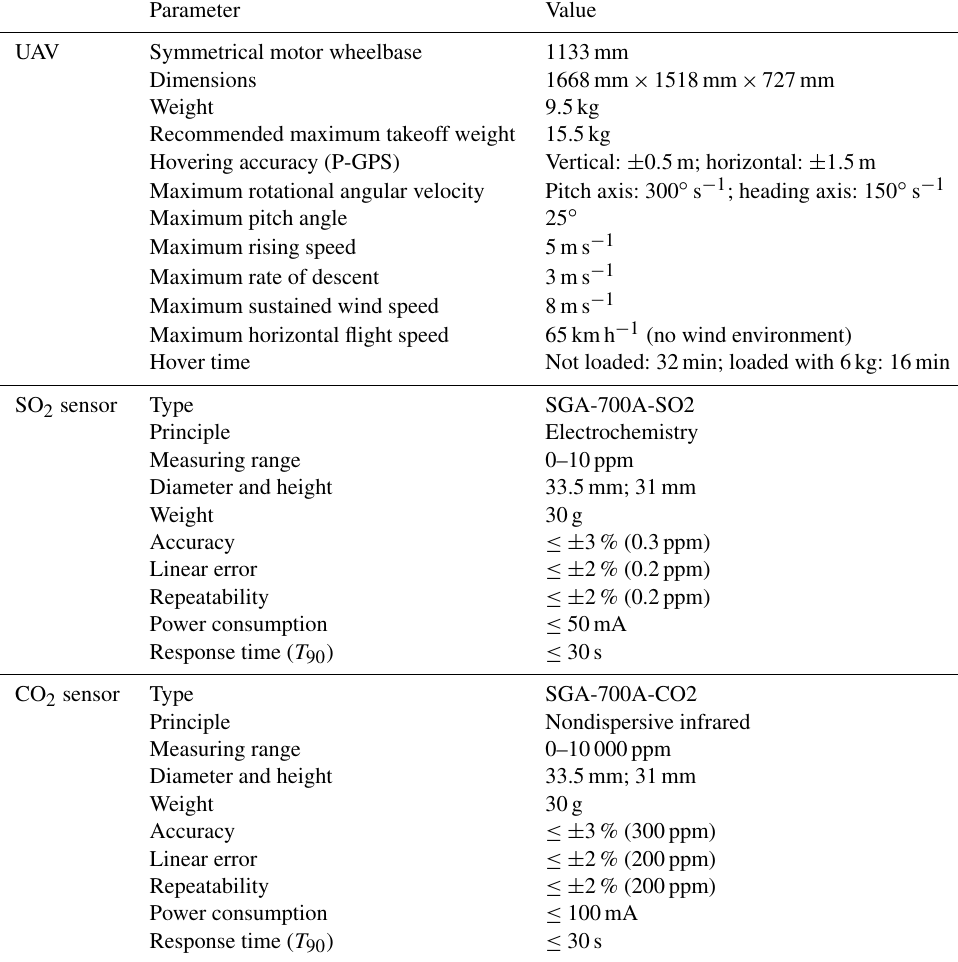
Table 1. Parameters of the UAV system.